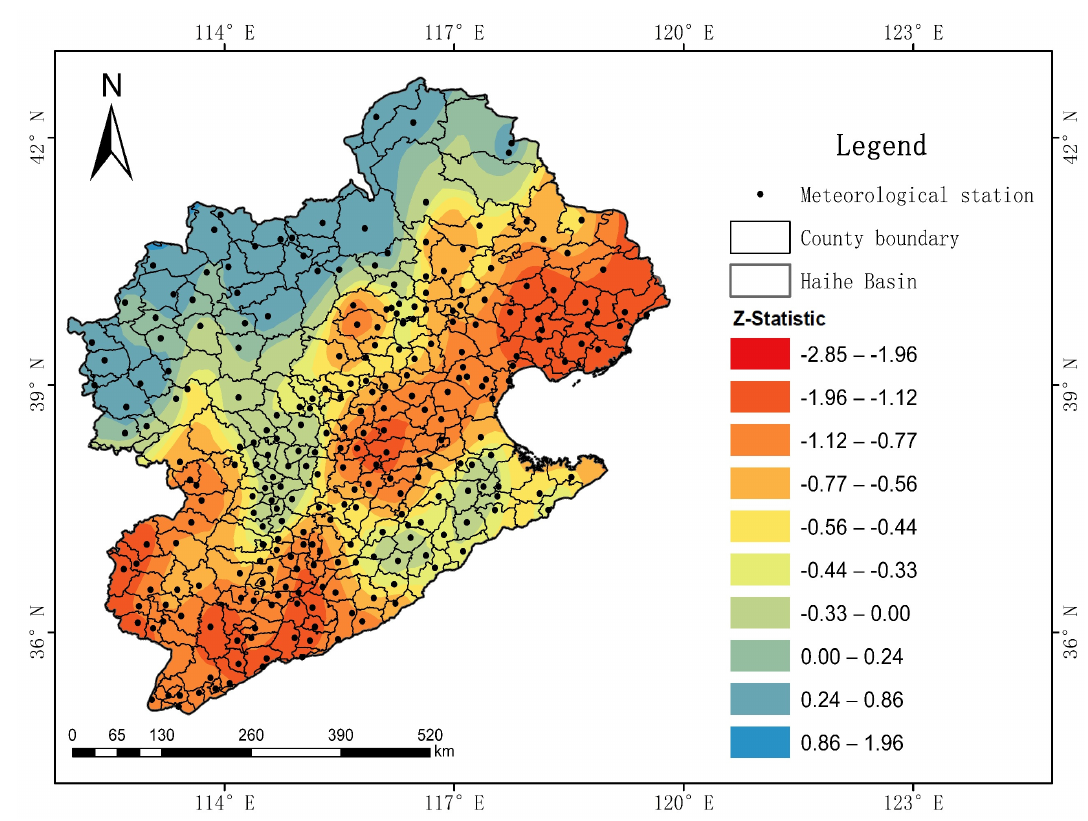
Figure 5. Spatial distribution of the significance of annual precipitation.